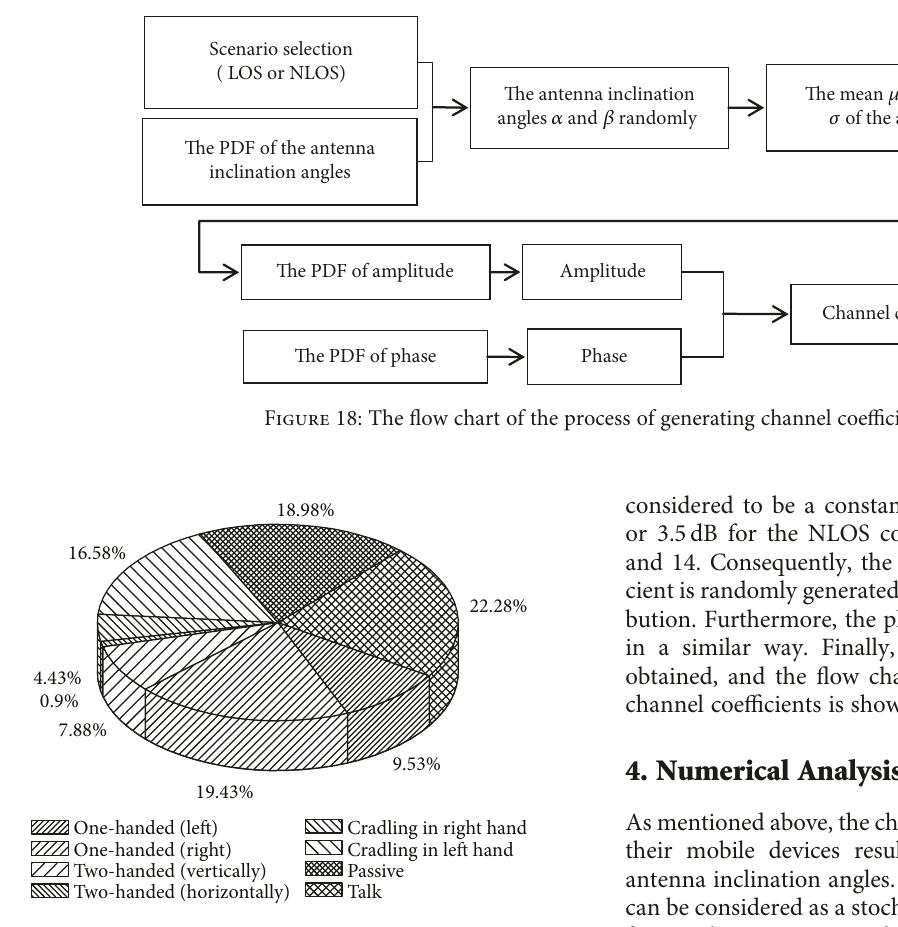
Figure 19: The pie chart of the survey results for people holding their mobile devices. Table 1: The relationship between the way of holding the mobile devices and the antenna inclination